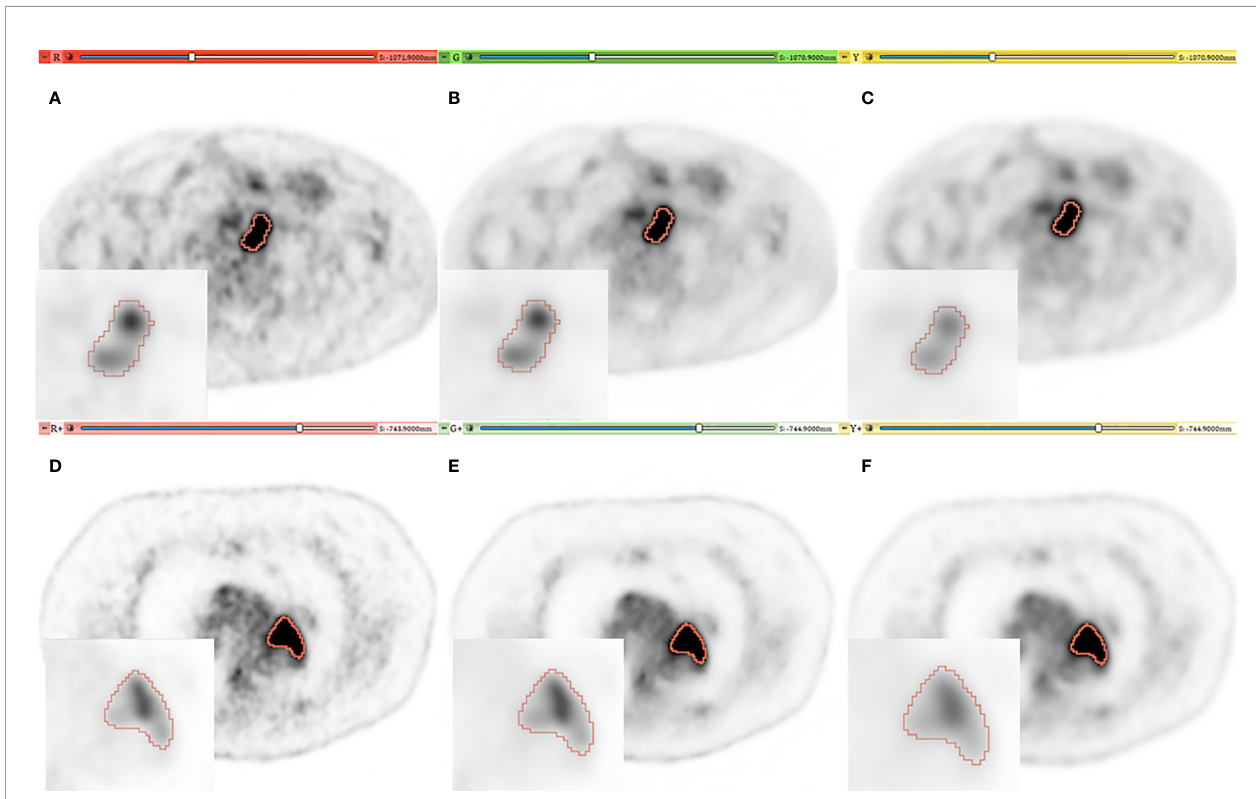
FIGURE 1 | Representative PET imaging of two lesions in different patients with a SUV windowing of (0 – 5). (A, D) [red], (B, E) [green], (C, F) [yellow] for original, AI and EARL images respectively. A Zoom is added on each image with SUV windowing between (0 – 25) and (0 – 30) for the fi rst and second